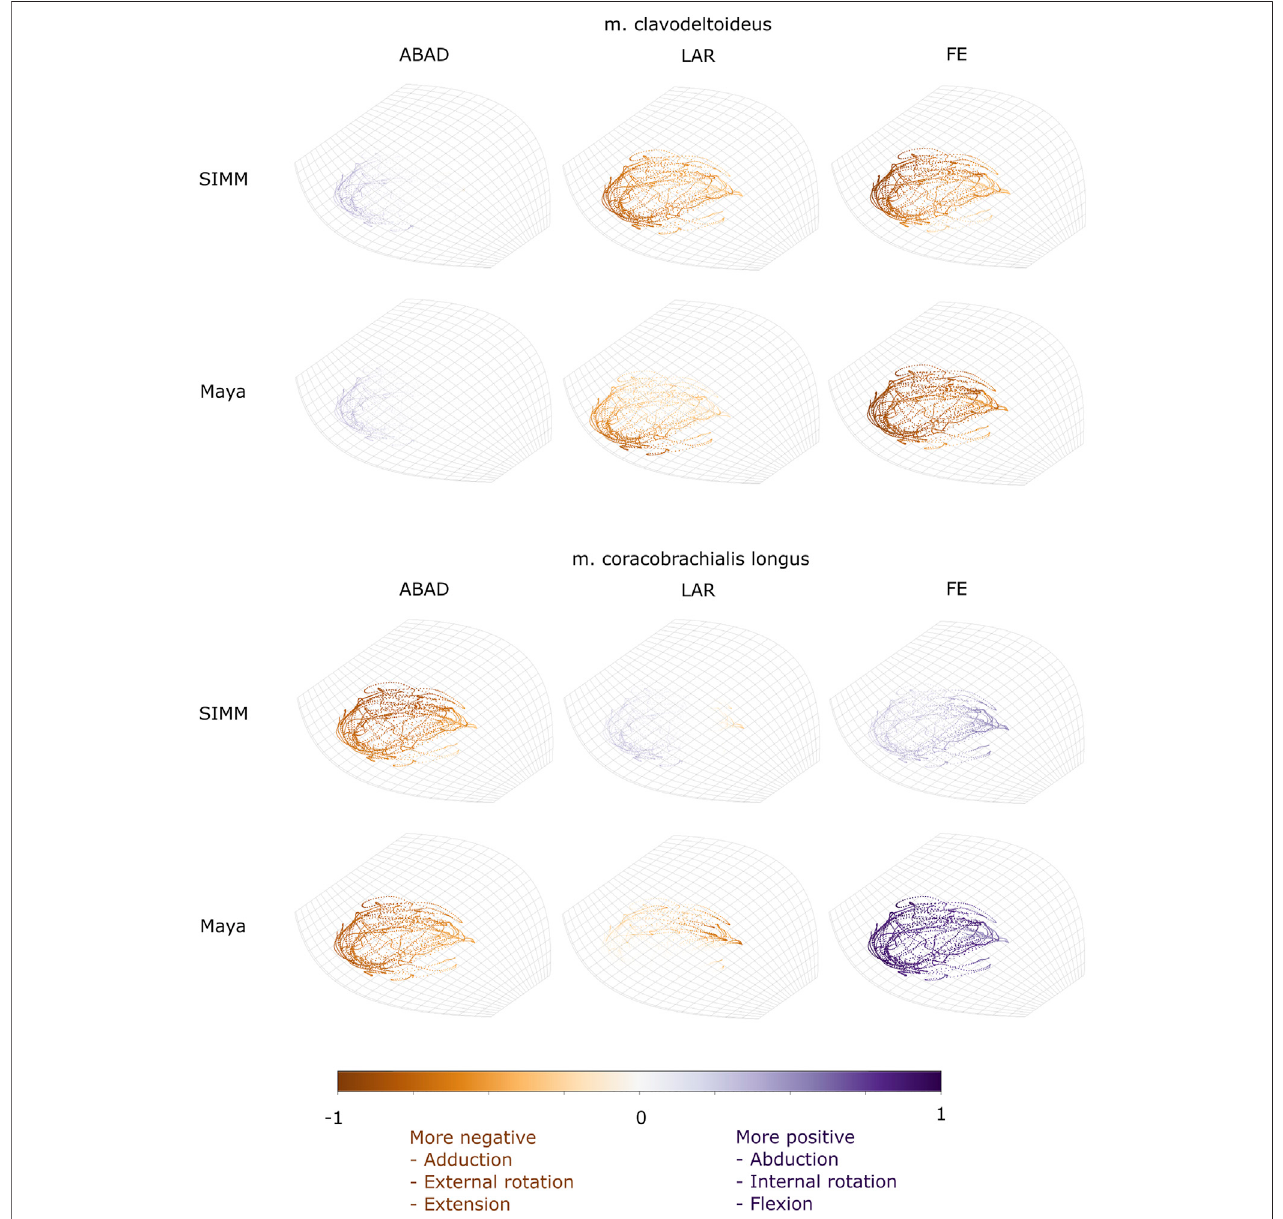
FIGURE8| Three-dimensional(3D)MMAsofm.clavodeltoideusandm.coracobrachialislongusattheglenohumeraljoint,plottedincosine-correctedROMspace for the SIMM model (using partial velocity) and Maya experimental data (using the geometric method). MMA sign is indicated by point colour (positive values are purple, negativevaluesareorange)withcolourintensityscaled torelative MMAmagnitudeasdescribed intheMethods. ABAD (cid:3) abduction-adduction; LAR (cid:3) long-axisrotation (internal-external rotation); FE (cid:3) fl exion-extension.